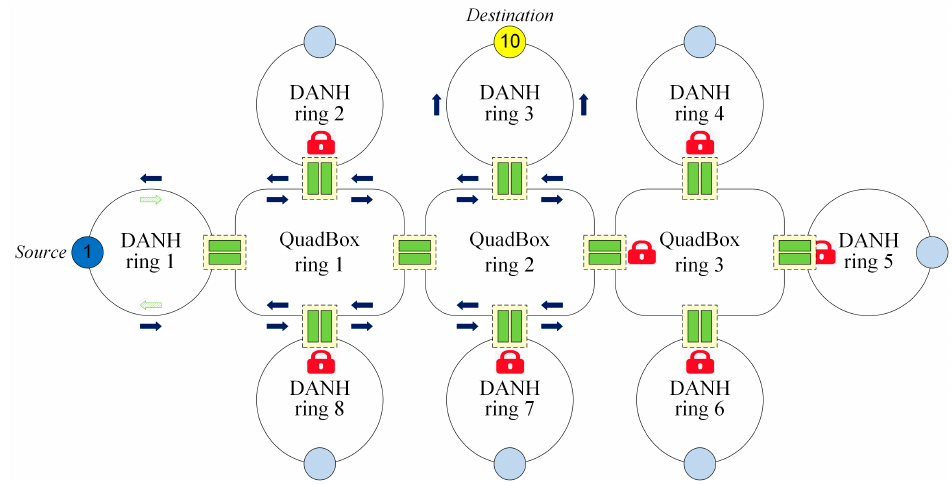
Figure 6. Forwarding a unicast frame using the enhanced port locking (EPL) technique.